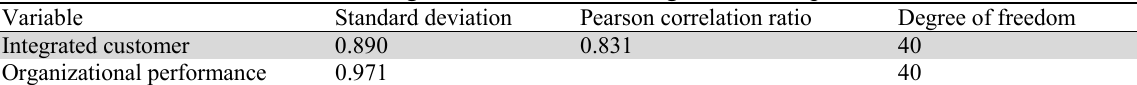
Pearson correlation test between integrated customer and organizational performance Variable Standard deviation Integrated